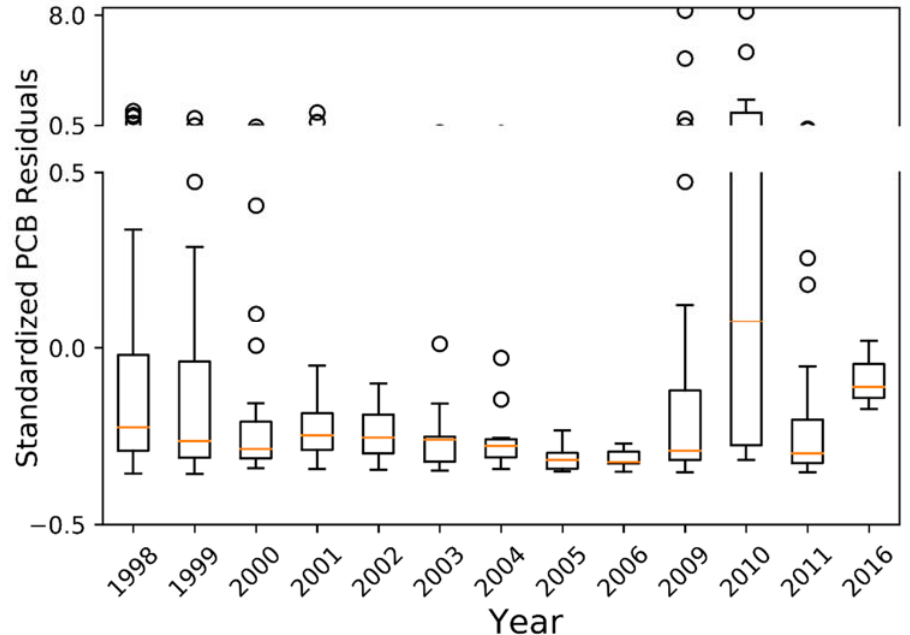
Figure 6. Box plot comparing standardized PCB residuals over time across the entire SFB. Orange lines represent median values, while lower and upper box boundaries represent the 1st and 3rd quartiles (Q1 and Q3). The upper whisker represents the highest datum less than Q3 + interquartile range (IQR) × 1.5; likewise, the lower whisker represents the lowest datum greater than Q1 − 1.5 × IQR. Note the split y -axis. Open circles outlying data points.